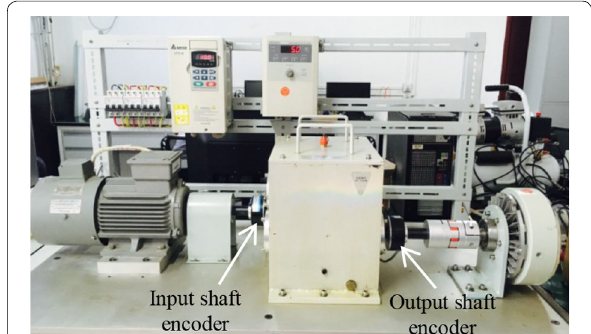
Figure 4 Two-stage spur gearbox test system